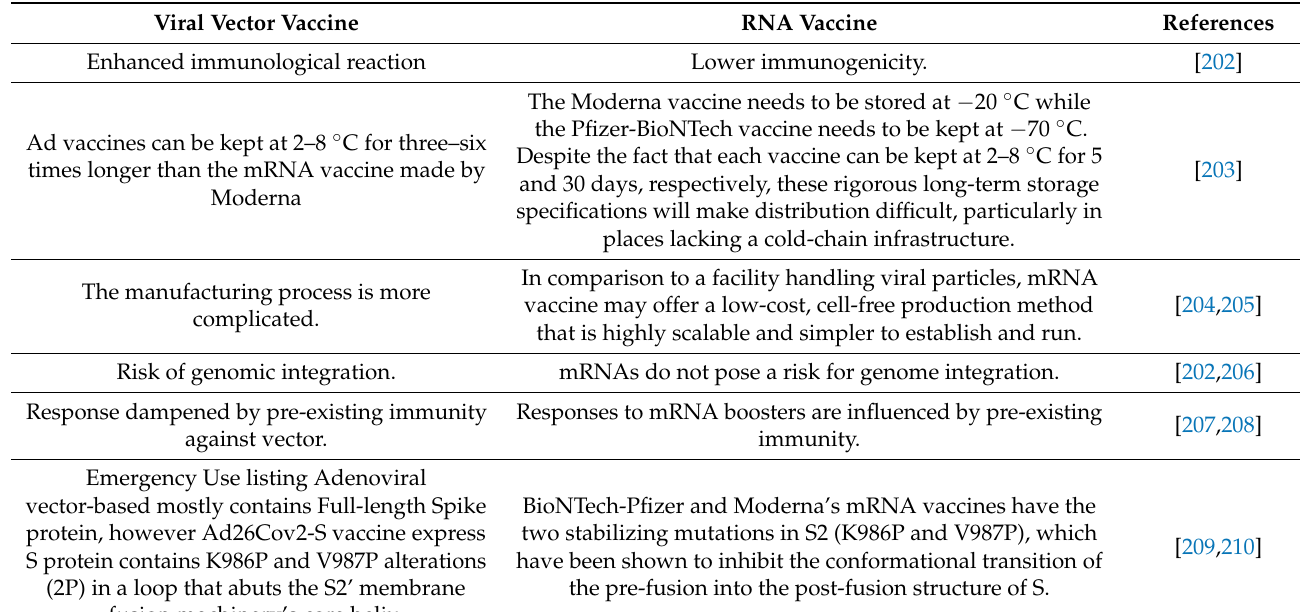
Table 4. Difference between Viral Vector Vaccine and RNA